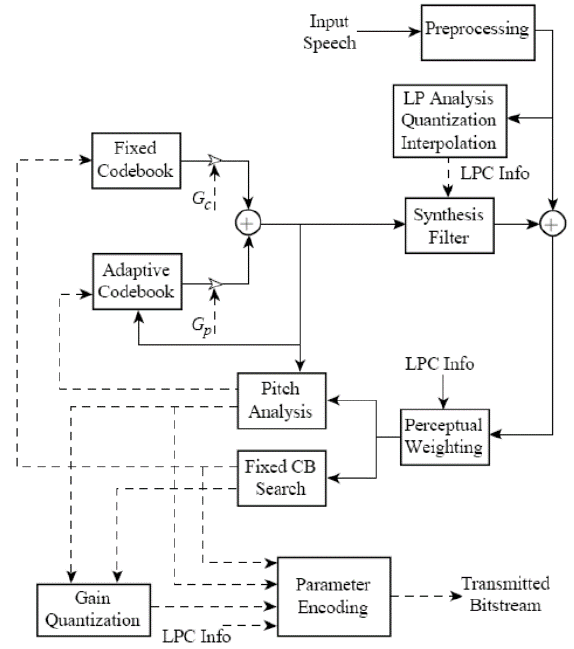
Figure 1. Code-excited linear prediction (CELP)